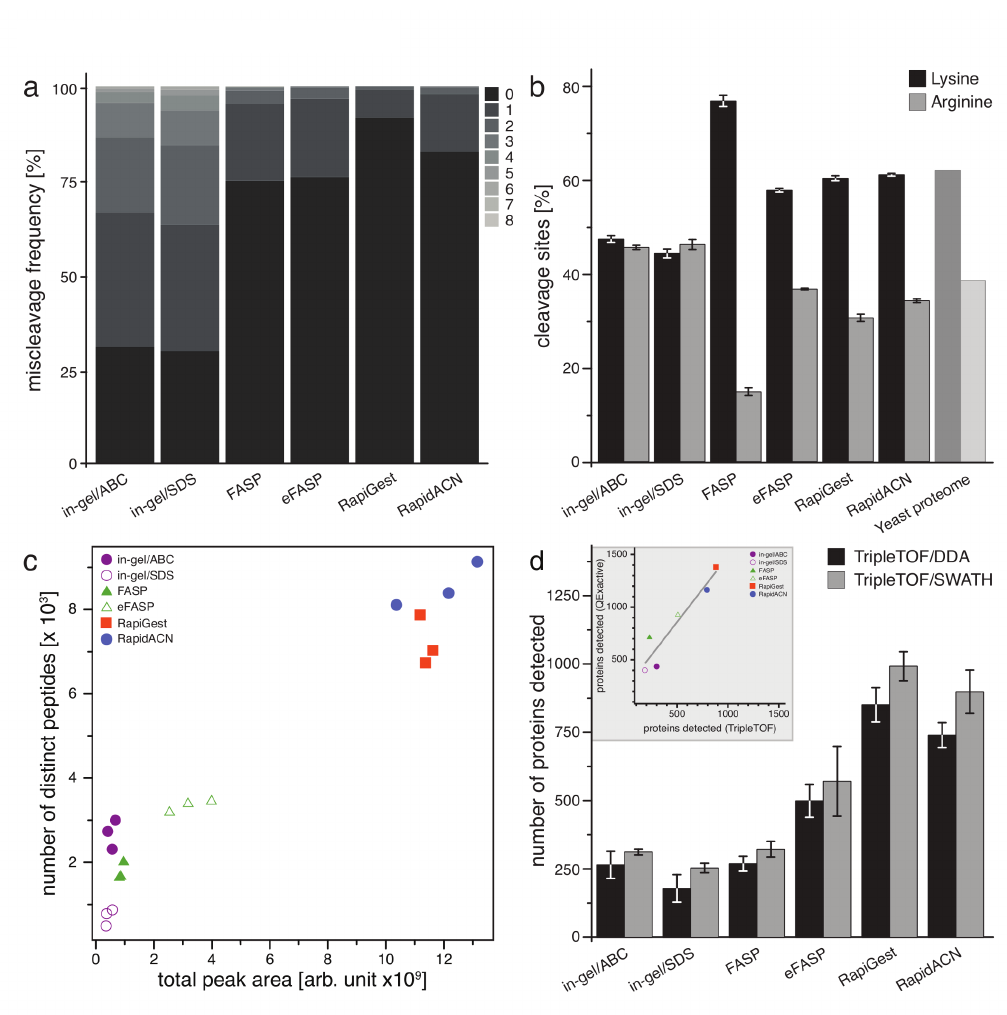
Figure 2. Protein identification in label-free sample preparations. ( a ) Proteolytic digestion efficiencies. Trypsin or Lys-C/trypsin (FASP) digestion efficiencies expressed as relative occurrence of spectra that could be assigned miscleaved peptides (n = 3). ( b ) Amino acid specificity of proteolytic digestion. Relative occurrence of identified peptides with C-terminal lysine or arginine, compared to the average frequency of these amino acids across all individual proteins identified (n = 3, Error bars = +/- S.D.) ( c ) Identified peptides differ per protocol, and correlate with the total peak area as recorded in a DDA experiment. 18 samples derived from the same yeast culture were processed with six protocols in triplicates, and analyzed on a TripleTOF5600 instrument. The number of identified peptides correlates with the total peak area recorded, and indicates the highest identification rate in in solution digests, followed by filter-aided , and in gel procedures. ( d ) Detection of proteins by DDA or SWATH in a label-free experiment. Samples were analyzed in triplicates both for DDA and